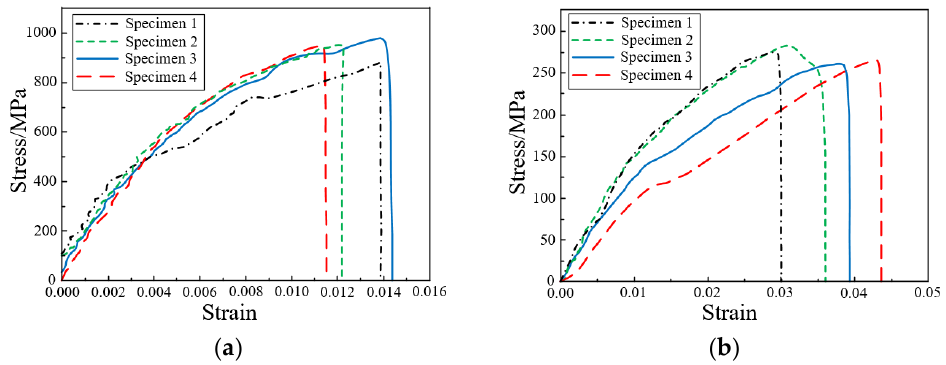
Figure 5. Uniaxial compression tests at 0° and 90° layer: ( a ) Test machine; ( b ) Uniaxial compression specimen; ( c ) Failure forms of specimens.